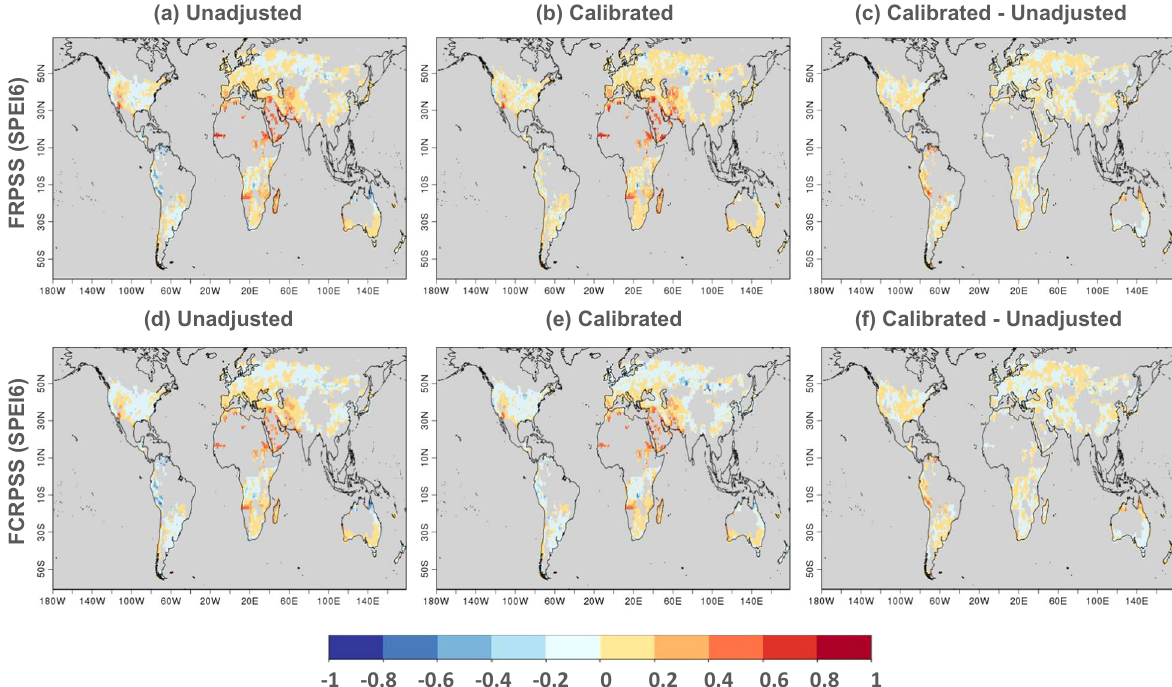
Fig. 1 Predictive skill of the drought index. Fair Ranked Probability Skill Score (FRPSS) for tercile events (top) and Fair Continuous Ranked Probability Skill Score (FCRPSS) for the full probability distribution (bottom) of unadjusted ( a , d ) and calibrated ( b , e ) SPEI6 forecast averaged over forecast years 1 – 5, with respect to the reference climatology during the wheat harvest months for the period 1961 – 2018. c , f presents the difference between calibrated and unadjusted